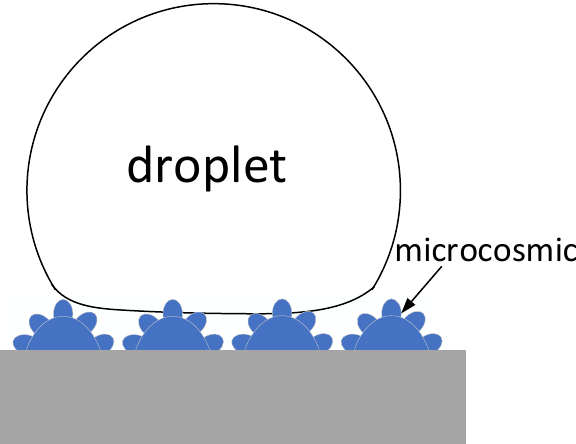
Figure 20. Droplets attached on the surface of superhydrophobic material in microcosmic.